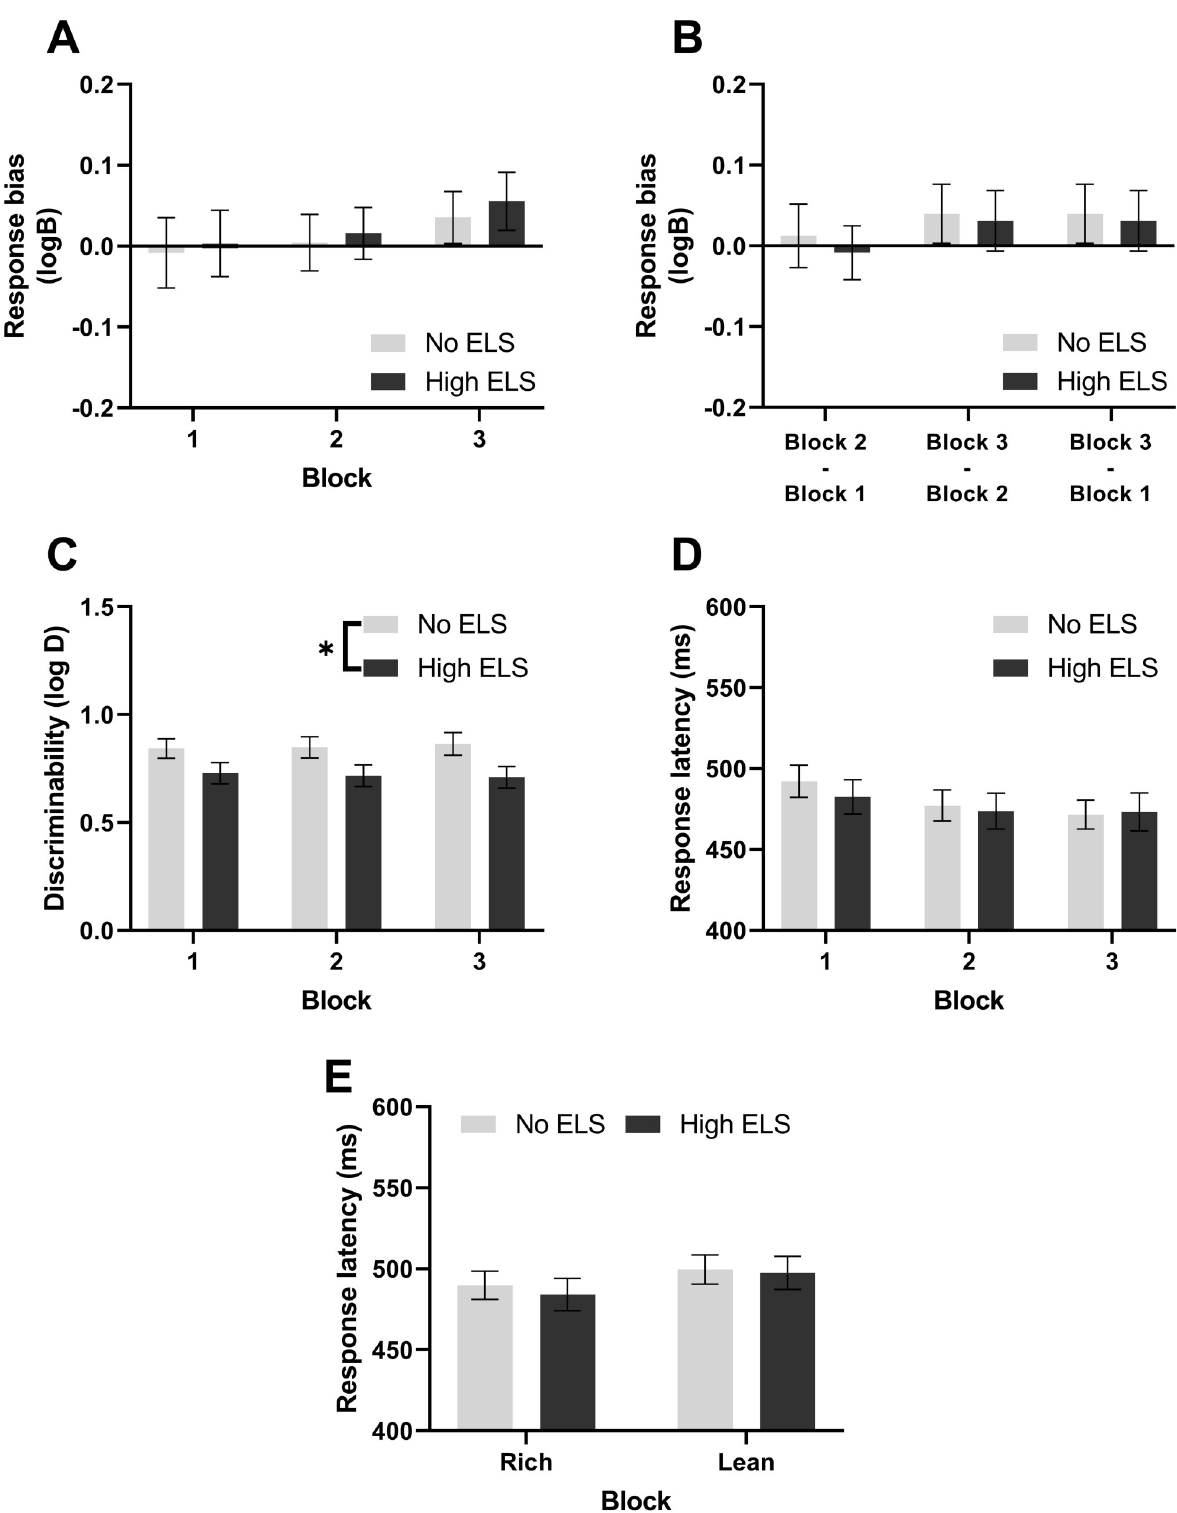
Fig 4. Participants with a history of ELS show decreased discriminability in the PRT. (A) Response bias to the more highly rewarded stimulus, (B) response bias development between blocks, (C) discriminability between long and short face lengths, (D) average response latency split by block and (E) response latency split by stimulus